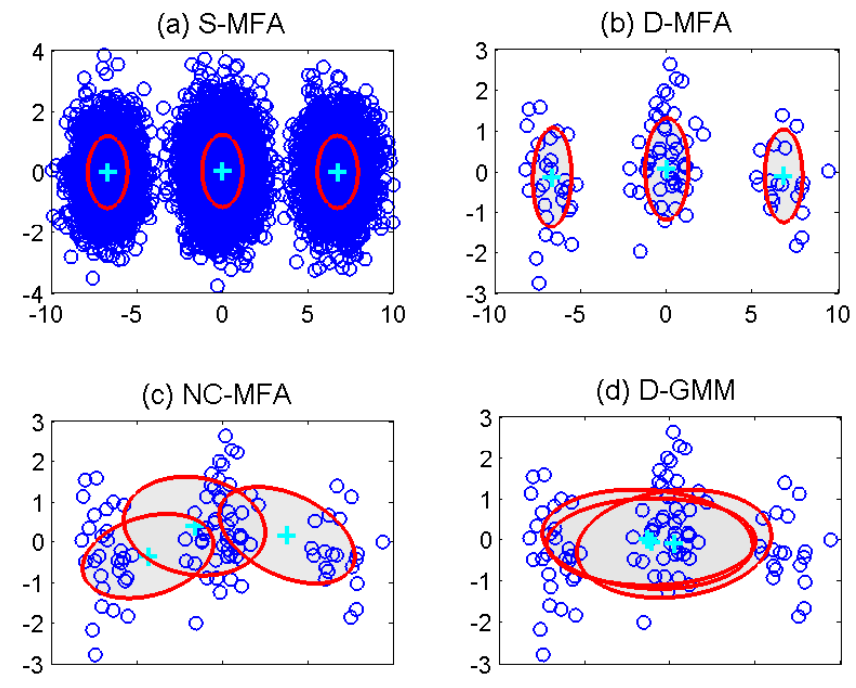
Figure 3. Scatter plot of observations with the estimated parameters at 2D principal